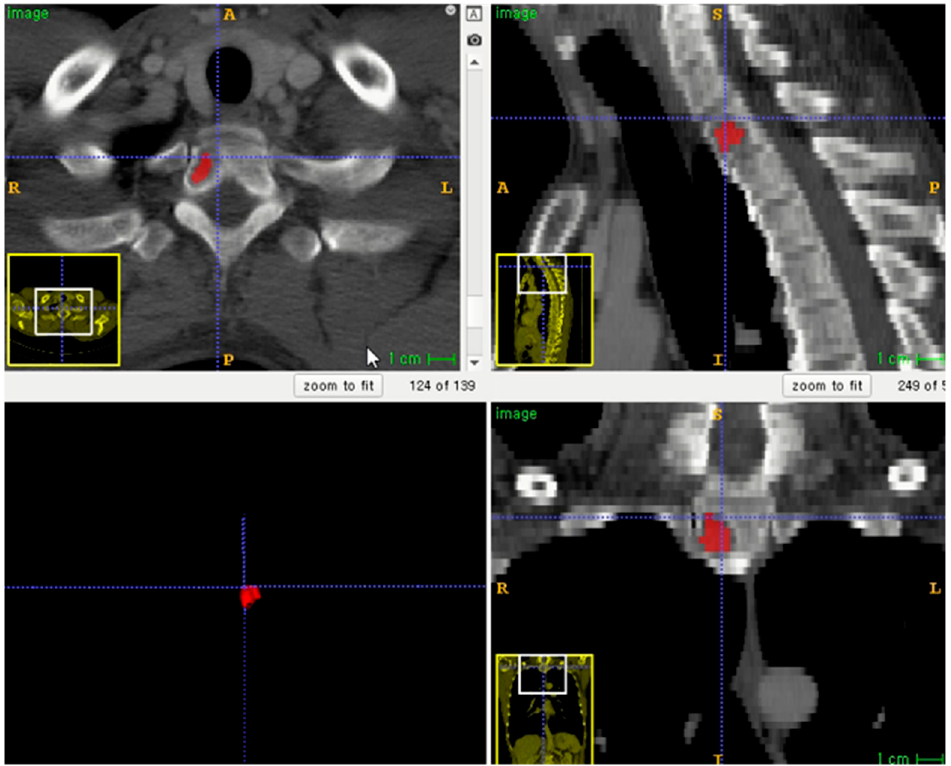
Figure 2. Example of lesion segmentation on axial skeleton.